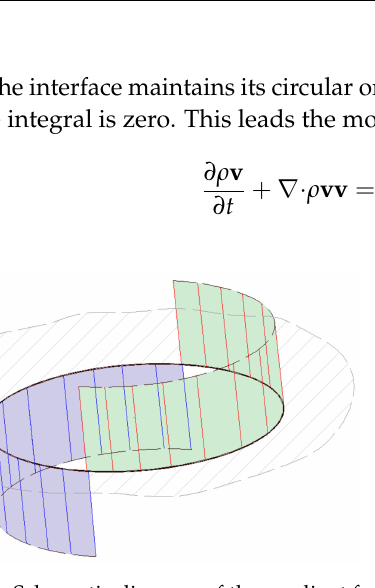
Figure 2. Schematic diagram of the gradient function of the phase function, ϕ . The gradient is zero in every way except at the interface, where it jumps as a positive delta function on half the interface and a negative delta function over the second half. Therefore, its integral over the whole interface is